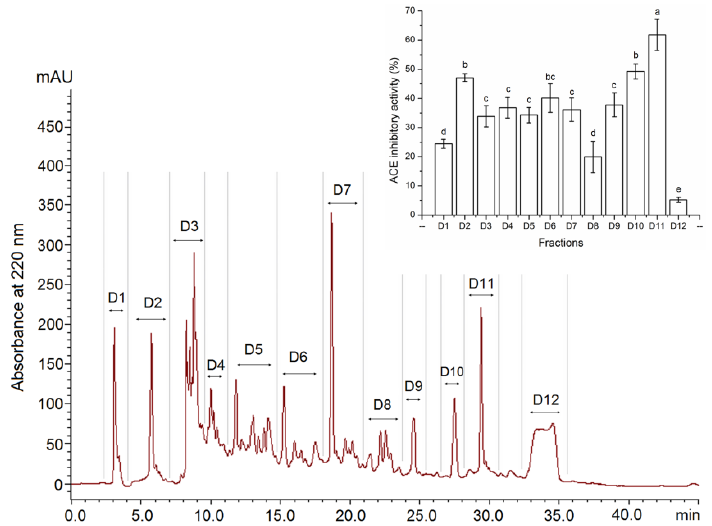
Figure 2. Semi-preparative RP-HPLC profiles of fraction D and ACE inhibition activity of each fraction. Different lowercase letters (e–g) above the bars indicate significant differences ( p < 0.05).